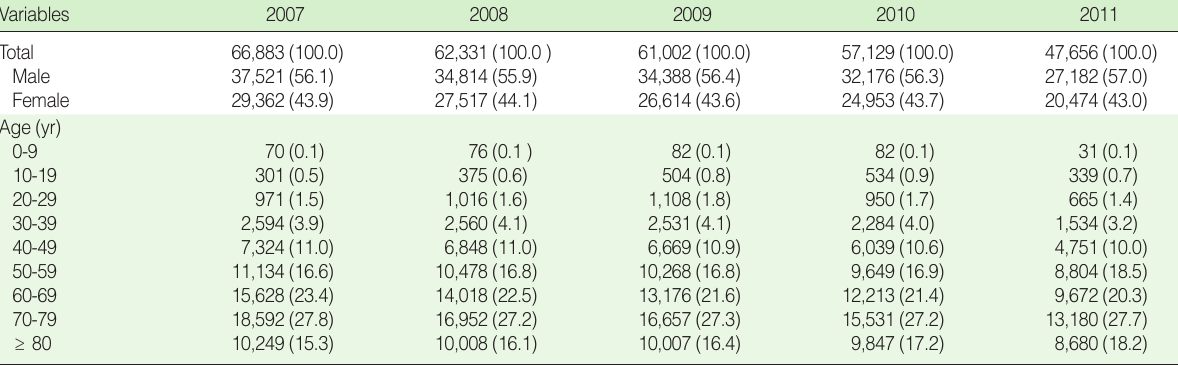
Table 2. Number of total admission episodes for acute myocardial infarction by year